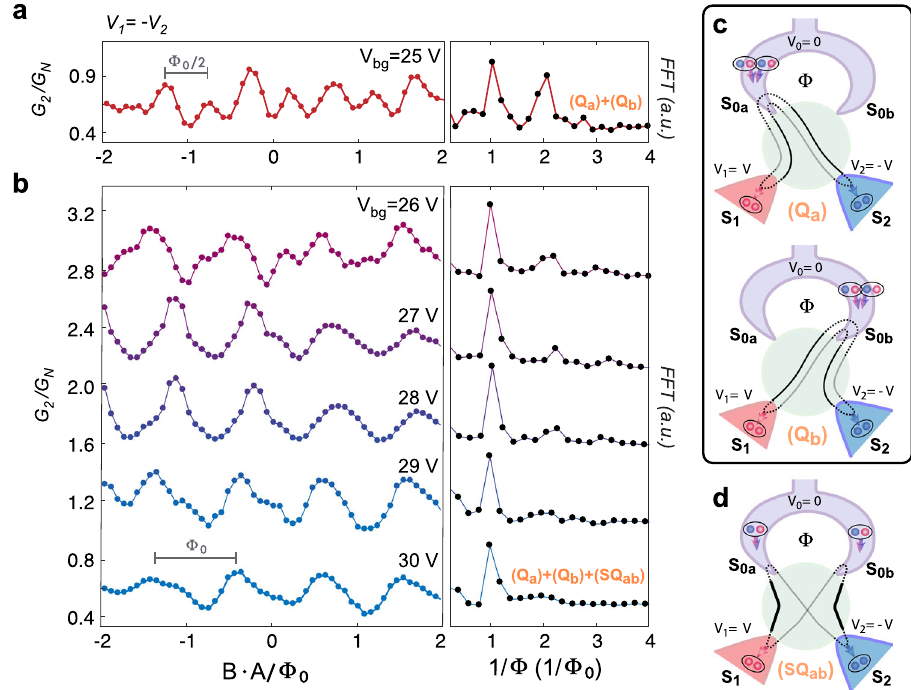
Fig. 3 Different types of quartet process. a Left panel shows the quartet differential conductance G 2 ( = δ I 2 = δ V ) measured at S 2 as a function of the fl ux Φ ¼ B (cid:4) A = Φ = 25 V. In the right panel, discrete Fourier transform (DFT) analysis of the data shows prominent harmonics, a consequence of 8 0 , where V bg oscillations in the left panel. The quartet is biased at V 1 = − V 2 = 0.4 mV, where the DC 2e process and MARs are not effective. b for V bg = 26 – 30 V. The periodicity evolves from half- fl ux quantum to one fl ux quantum as V bg increases. c (Q a ) (Q b ) shows the conventional three-terminal quartet process with only one out of the two loop contacts involved. Electron-hole conversion happens twice at the same contact of the loop (either S 0 a or S 0 b ), resulting in periodicity of half- fl ux quantum. d (SQ ab ) shows the split-quartet process involving both contacts of the loop. With the odd parity of Cooper pairs transferred, the periodicity is one fl ux